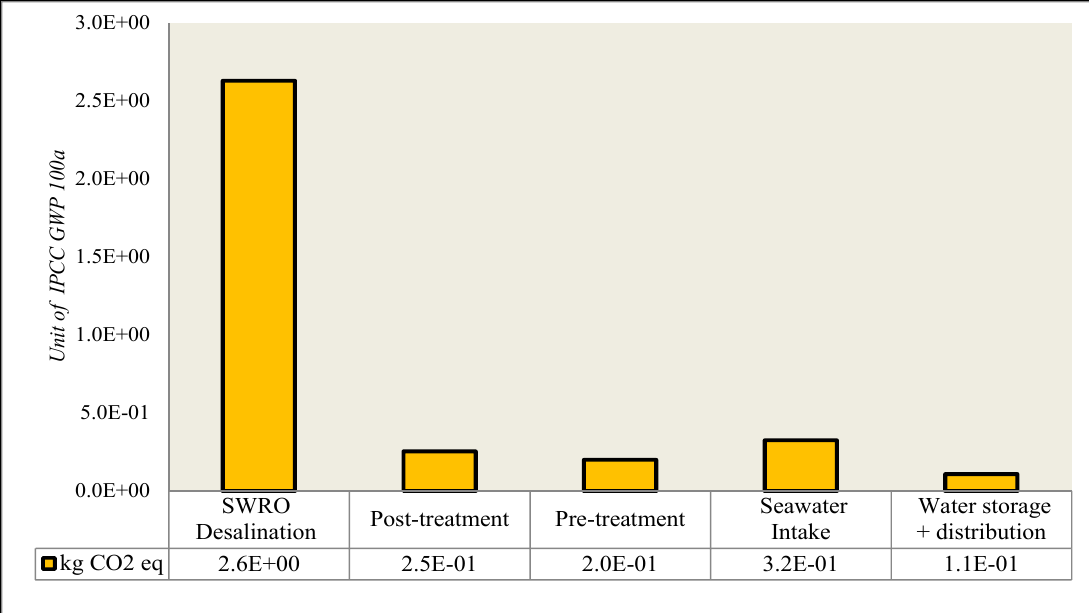
Figure 3. Contribution of relative carbon footprint, according to phase of process, by SWRO in the operation stage. Table 4. Comparison of carbon footprint emissions from Malaysia and other